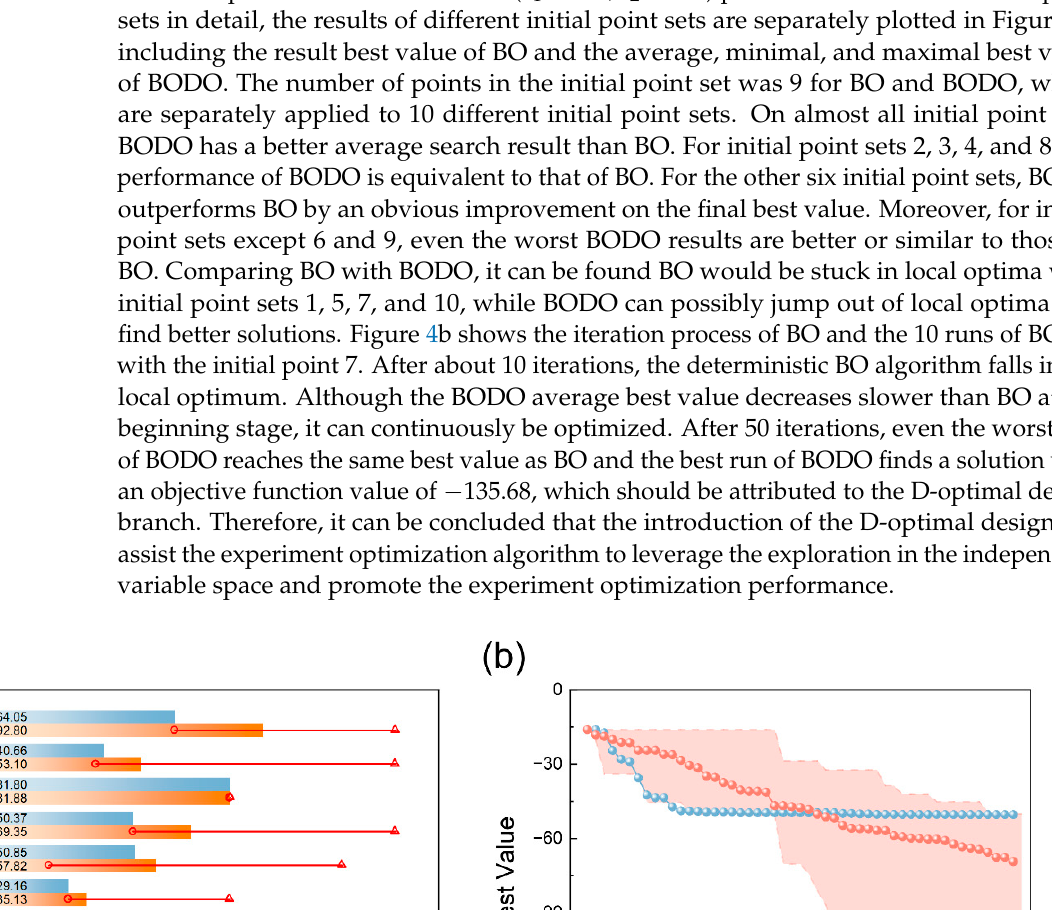
Figure 5. The average BODO performance with different 𝛽 settings (1.00, 0.98, 0.95, 0.90, and 0.85) on ( a ) alpine2 3d , ( b ) alpine2 5d , and ( c ) alpine2 8d test functions. BODO is run for 10 times over 10 random initial point sets. The initial point sets are the same for all 𝛽 settings. For all alpine2 test functions, the best value decreases faster in the early stage when 𝛽 is set smaller. This is because a smaller 𝛽 value means a relatively larger probability in the BO branch for exploitation. However, after a certain number of iterations, a larger 𝛽 value can lead to a better best value for its inclination toward exploration through the D- optimal branch. With regard to the final best value, the best 𝛽 setting is 1.00 for all alpine2 test functions because the exploration probability does not decrease with the experiment